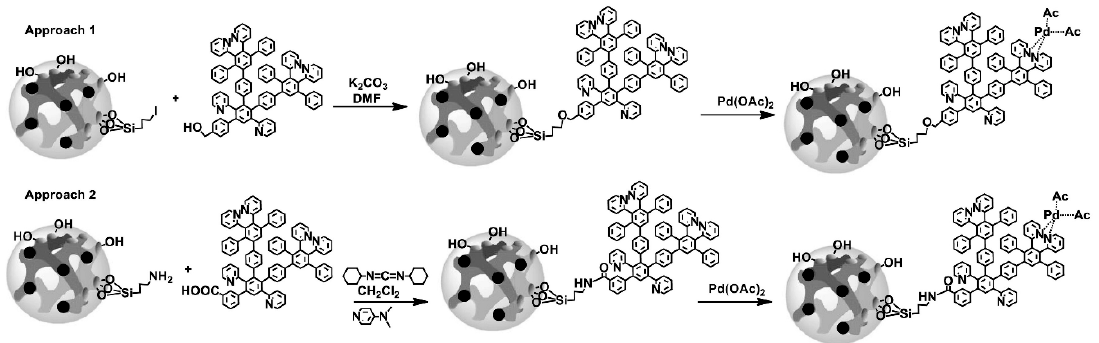
Figure 9. Attachment of Pyridylphenylene dendrons to magnetic silica with the aid of iodine (Approach 1) or amino (Approach 2) groups succeeded by the complexation with Pd acetate. (Reproduced with permission from [86]; Copyright Elsevier, 2019).